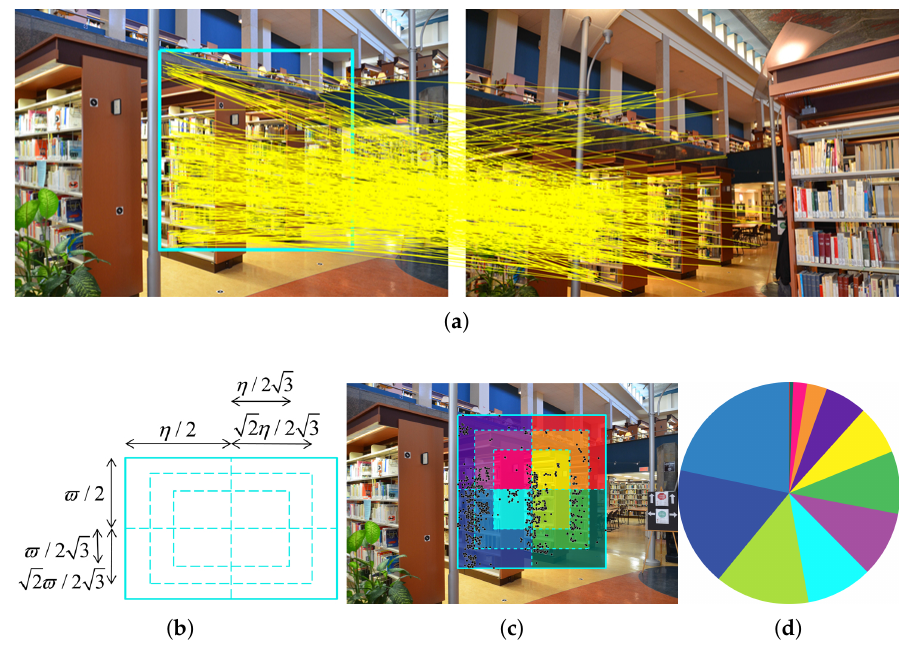
Figure 3. Guided sampling: ( a ) a stereo pair and the putative correspondences; the bounding rectangle on the left image represents the overlapping rectangle; ( b ) dividing the overlapping rectangle into 12 sub-regions of equal area; ( c ) the minimal rectangle and the distribution of putative matches over the sub-regions; ( d ) density-based roulette-wheel for region